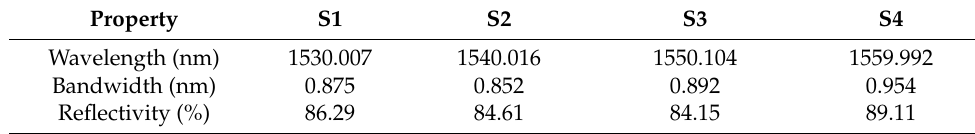
Table 1. Properties of the grating sensors S1, S2, S3, and S4 (DK Photonics). Property S1